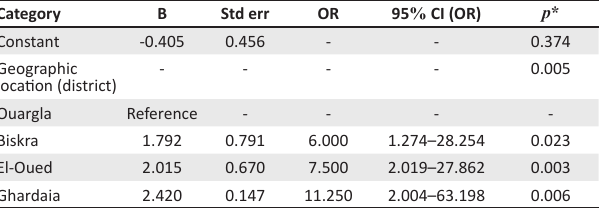
TABLE 4: Risk factors for herd-level infection with Trypanosoma evansi amongst dromedary camel populations in southeastern Algeria.